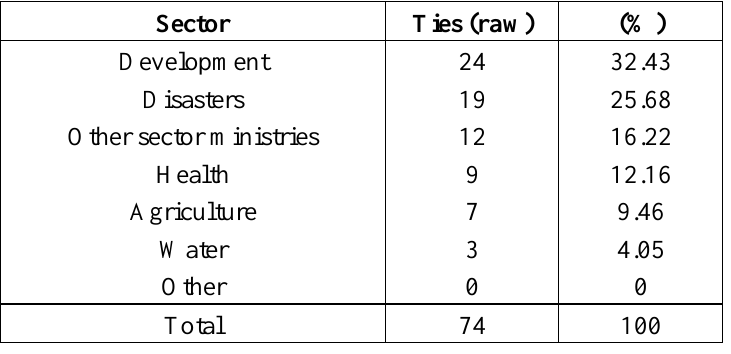
Table 10. Climate change adaptation informal partnership